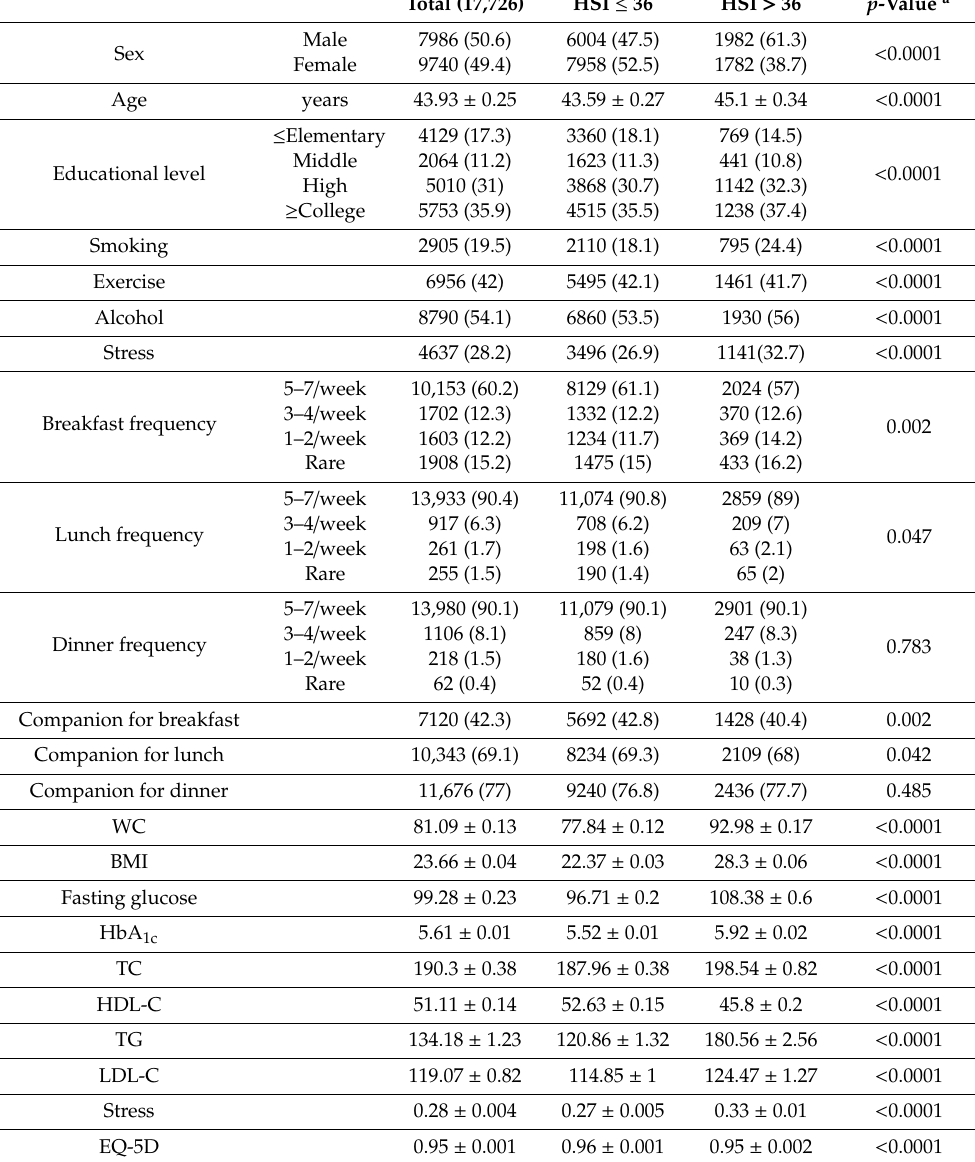
Table 1. Di ff erences between general characteristics and dietary habits, stress, HRQoL, and